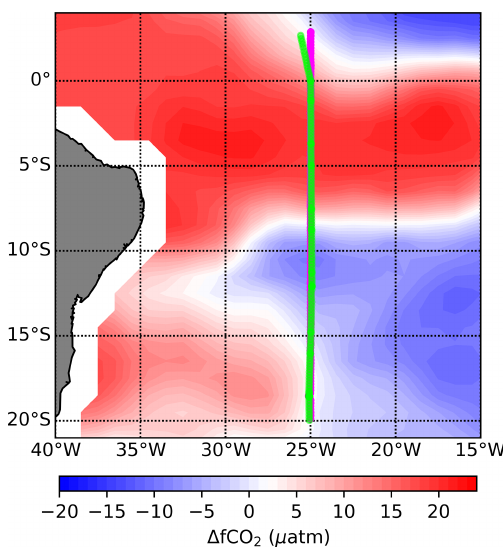
Figure A2. Cruise tracks of AMT28 (magenta) and AMT29 (green). The ocean is coloured with the (cid:49)f CO 2 for October 2018 (Bakker et al., 2016; Landschützer et al.,